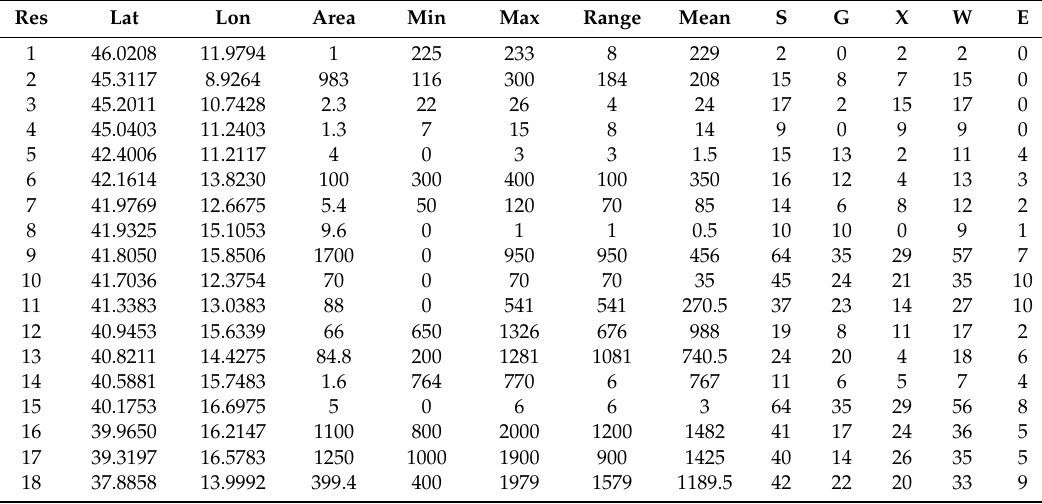
Table 1. Number of species for various beetle groups in Italian reserves. Location, area, and elevation of reserves are also given. Res: Reserve number (reserves are numbered as in Figure 1), Lat: Latitude (decimal degrees), Long: Longitude (decimal degrees), Area: reserve size (km 2 ), Min: Minimum elevation (m), Max: Maximum elevation (m), Range: Elevational range (m), Mean: Mean elevation (m). Tenebrionid groups: S: Total species richness, G = Geophilous species, X = Xylophilous species, W = widespread species, E = Endemic